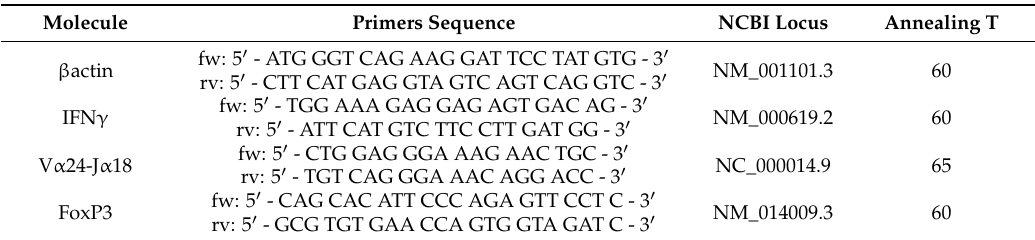
Table 2. Primer sequences for